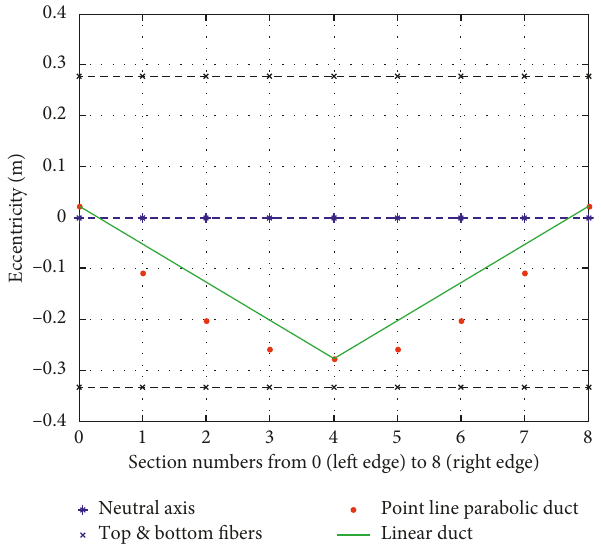
Figure 7: Ideal tendon profile based on the Magnel diagram of 9 cross sections each L /8